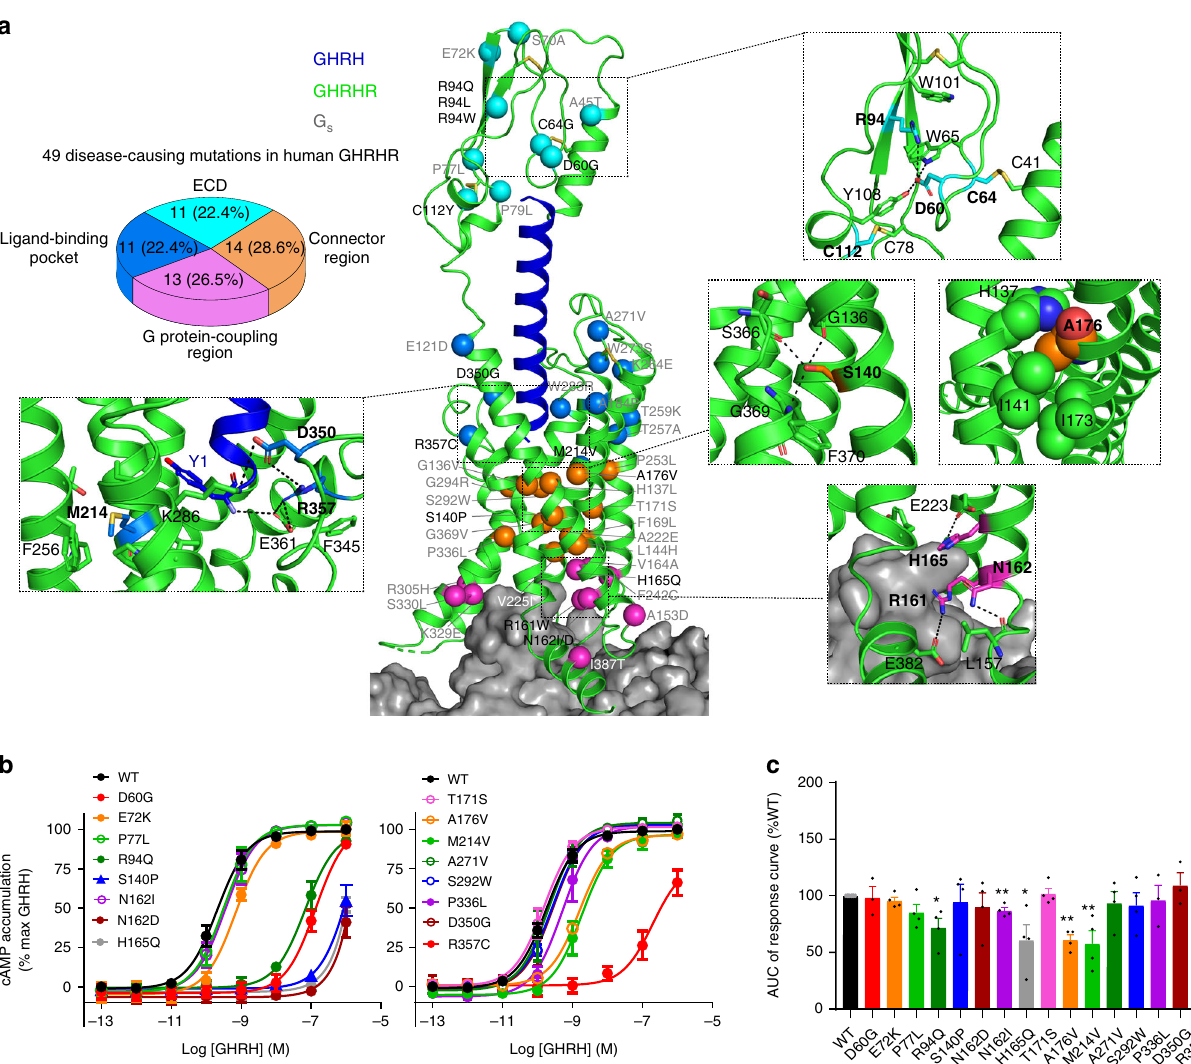
Fig. 4 Disease-causing missense mutations of GHRHR. IGHD refers to conditions of growth hormone de fi ciency that are not necessarily associated with other pituitary hormone de fi ciencies or with an organic lesion. While there is no single cause identi fi ed for IGHD, defects in growth hormone, GHRHR and GH1 genes are implicated as causative factors 55 . Of which, naturally occurring missense mutations of GHRHR have been studied extensively 56 . a Naturally occurring mutations in the ECD, ligand-binding pocket, and G-protein-coupling region are colored cyan, marine, and magenta, respectively. The central region connecting the ligand-binding pocket and G-protein-coupling region is colored orange. b , c Functional assessment of effects of disease-causing GHRHR mutations on G s -mediated cAMP accumulation ( b ) and β -arrestin2 recruitment ( c ), cAMP accumulation assays and β -arrestin2 recruitment were performed in HEK 293 T cells and data shown are means ± S.E.M. of at least three independent experiments ( n = 3 – 8), performed in quadruplicate or duplicate, respectively. Statistically signi fi cant differences were determined with a two-tailed Student ’ s t test. * P < 0.05, ** P < 0.01 vs. wild type (WT); AUC area-under-the-curve. Source data are provided as a Source data fi